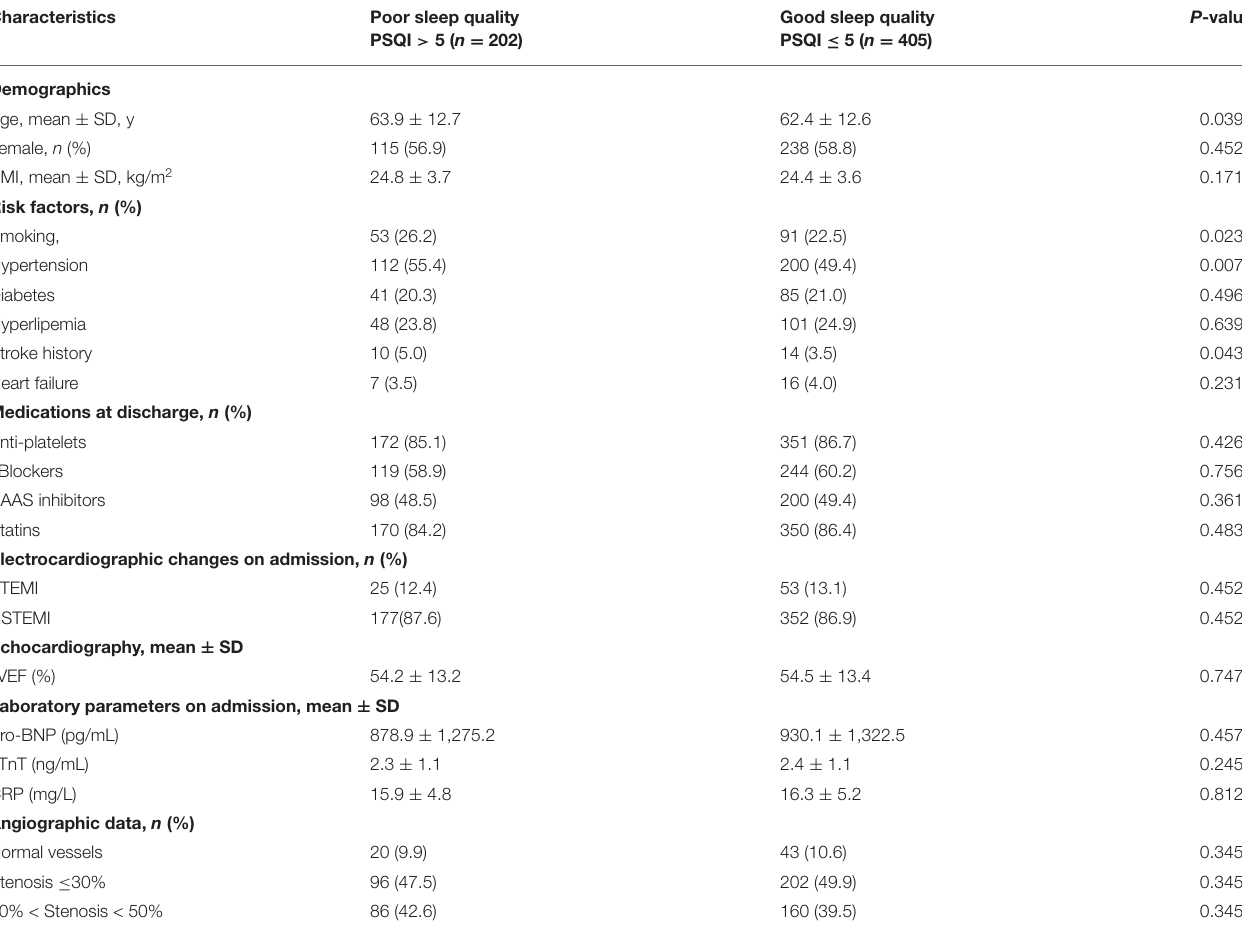
TABLE 1 | Demographic and clinical characteristics of the study population with poor sleep quality and good sleep quality.